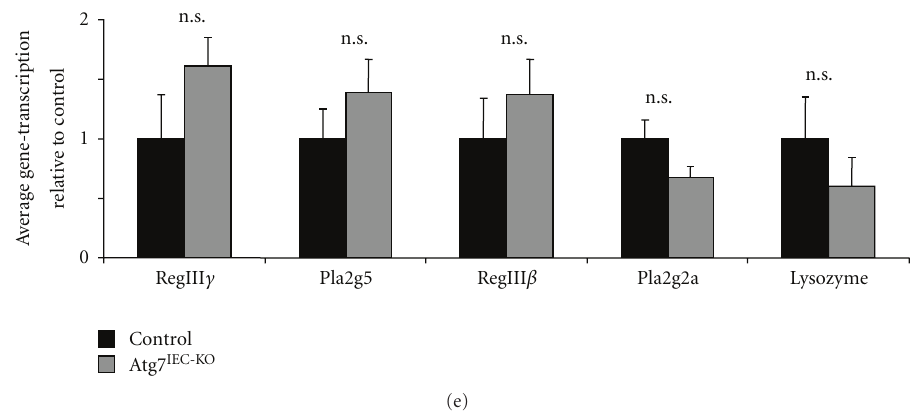
Figure 2: Paneth cell function in unchallenged control and Atg7 IEC-KO mice. (a) Histological analysis of Paneth cells by trichromatic staining with alcian blue, PAS, and Elastica van Gieson (top) and by electron microscopy (EM, bottom, 2156x magnification) demonstrates smaller size of granules (black arrows) in Atg7-deficient Paneth cells compared to control Paneth cells. Large autophagosomes (white arrow) were detectable in electron microscopic pictures of IECs derived from control mice but not of IECs derived from Atg7 IEC-KO mice. (b) Immunofluorescent staining of distal small intestine for lysozyme (red) reveals decreased levels of lysozyme in Atg7 deficient Paneth cells. Nuclei are shown in blue. (c) Statistical analysis of the number of cells containing granules (granular+) or lysozyme (lysozyme+) at the base of crypts in the distal small intestine of unchallenged control and Atg7 IEC-KO mice ( n = 187 control crypts and n = 140 Atg7 IEC-KO crypts for analysing granular+ cells, n = 75 control crypts and n = 43 Atg7 IEC-KO crypts for analysing lysozyme+ cells). (d) Detection of bacteria (red) in the distal small intestine of unchallenged control and Atg7 IEC-KO mice by fluorescence in situ hybridization (FISH). Nuclei are shown in blue. (e) Quantitative analysis of the transcription of antimicrobial peptide genes in the distal small intestine of unchallenged control and Atg7 IEC-KO mice. Data show mean values + SEM ( n = 5 control mice, n = 4 Atg7 IEC-KO